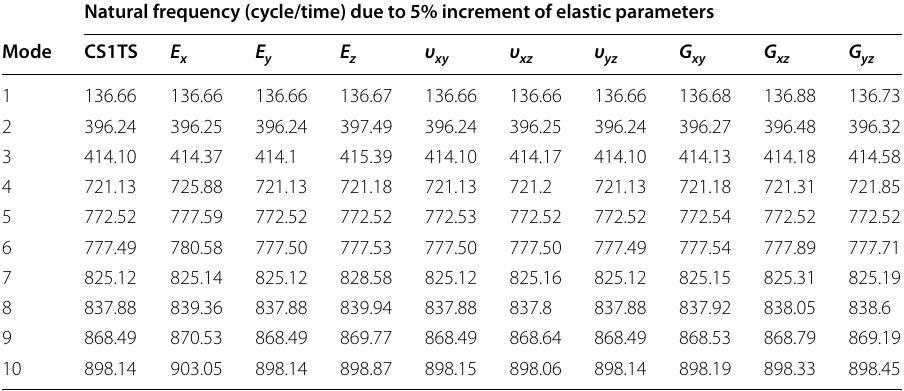
Table 6 Natural frequencies for the CS1TS after increasing 5% of face layer elastic parameters Natural frequency (cycle/time) due to 5% increment of elastic parameters